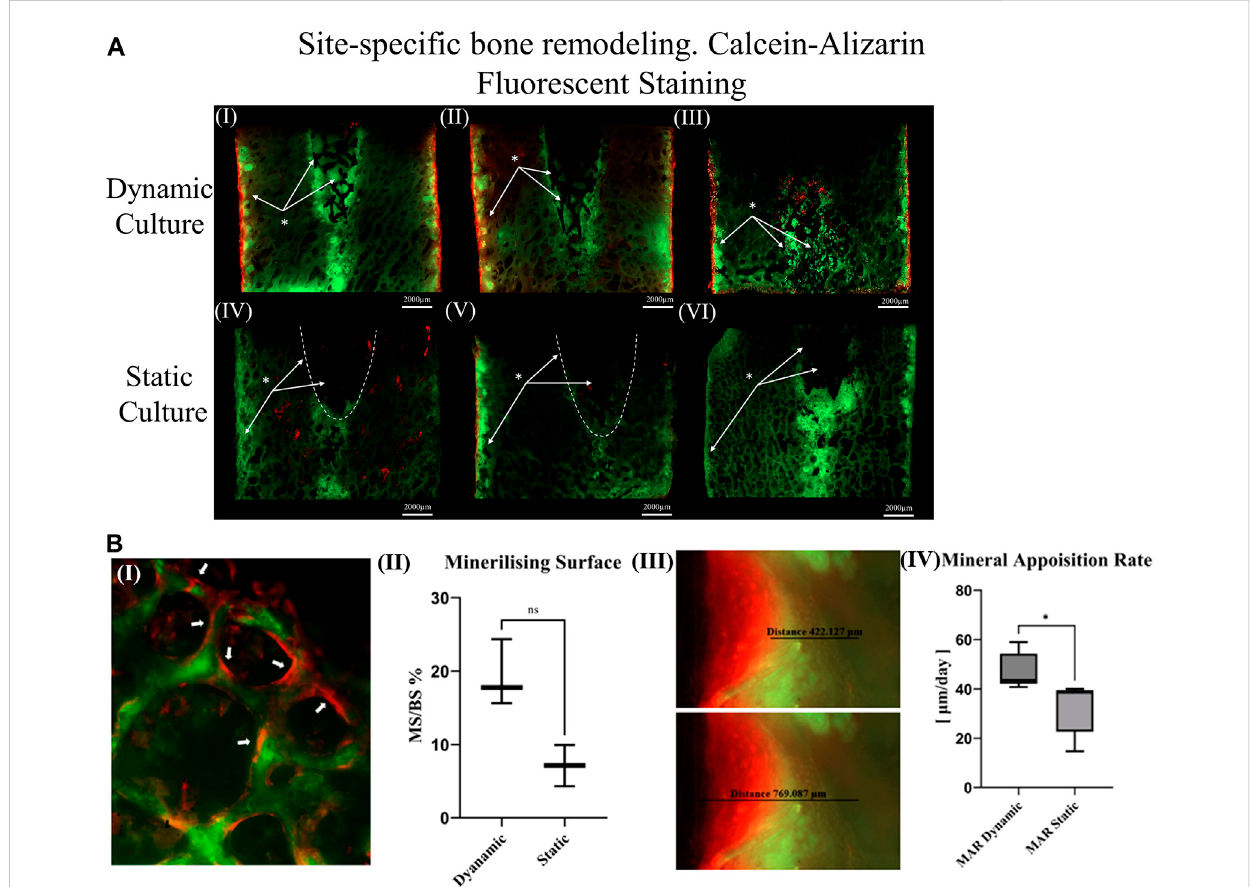
FIGURE 4 (A) Thinned sections (50 μ m/slice) of the bone cylinders stained with calcein on the seventh day and Alizarin red on the 14th day for three dynamic culture replicates (I-III) and three static culture replicates (IV-VI) (B) Representative images from dynamic samples. (B.I) Mineralizing surfaces (MS) evaluated from the bone struts found on the outer perimeter of the bone cylinders on the top surfaces. (B.II) Measurements of the MS/BS expressed in percentage.(B.III)Mineralappositionratefoundonthesidesofthebonecylinders(thinnedsections)and(B.IV)meandistanceofbothlabelsdivided by seven expressed in μ m/day. Values are means of n = 3 (±SD); * p <